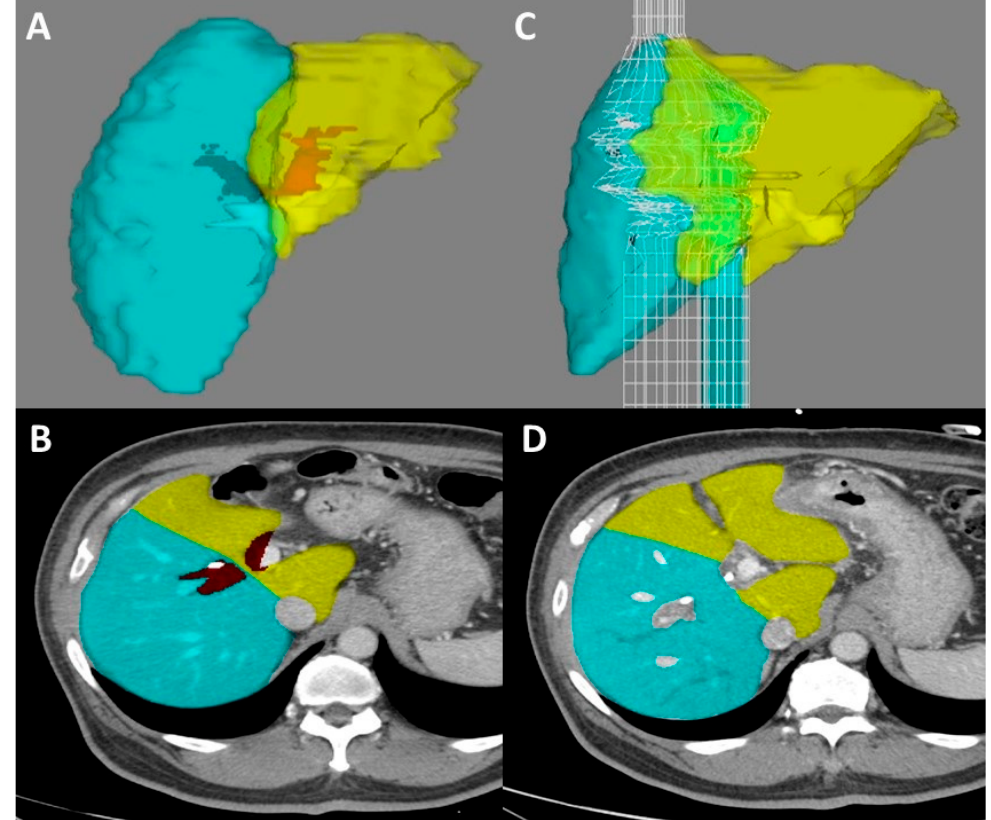
Figure 4. Preoperative and postoperative volumetric analysis with interval portal vein embolization. Computed tomography-based volumetric analysis (TeraRecon Inc., Durham, NC, USA) with perihilar cholangiocarcinoma. Prior to portal vein embolization (panels ( A , B )), functional liver remnant after planned right hepatectomy was calculated to be 31.9% (yellow). Patient underwent right portal vein embolization without embolization of Segment IV. After three weeks, repeat volumetry was performed (panels ( C , D )). The newly calculated FLR (yellow) was 45.9%, yielding a KGR of 4.7%.